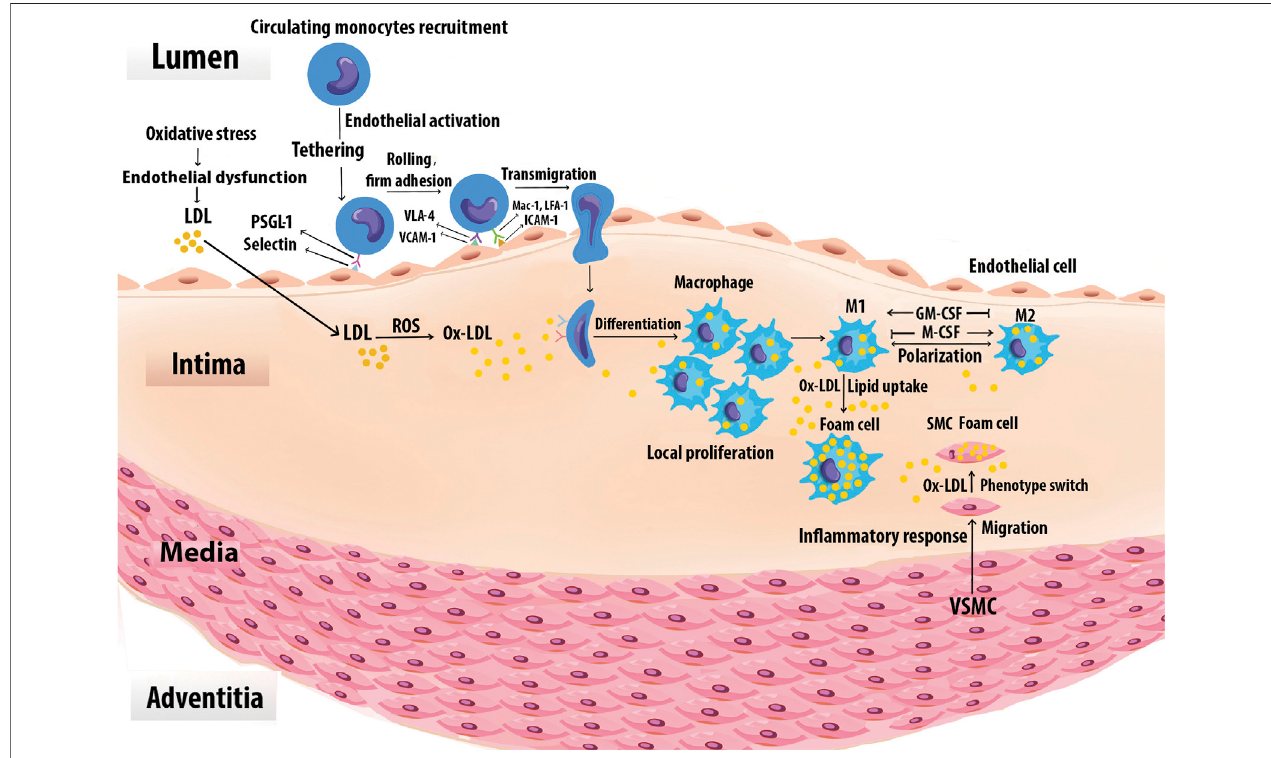
FIGURE 3 | Foam cell formation. Monocytes are recruited to the vascular arginase wall in response to Ox-LDL. Speci fi c adhesion molecules such as the selectins, VCAM-1, and ICAM-1 are expressed on the surface of activated vascular ECs, mediate monocyte adhesion. Once adherent, the monocytes enter the intima and differentiate into M φ s. The differentiation process may be mediated by GM-CSF and M-CSF. Local M φ proliferation contributes to lesion growth. Upon extensive uptake ofOx-LDLviaSRs, M φ sare ultimately turned intofoam cells. Chemoattractants, growth factors, and cytokines also promote SMCproliferation, uptake ofOx-LDL, and eventually conversion to foam cells. Foam cells derived from SMCs together with those derived from M φ s generate the fatty lesion.